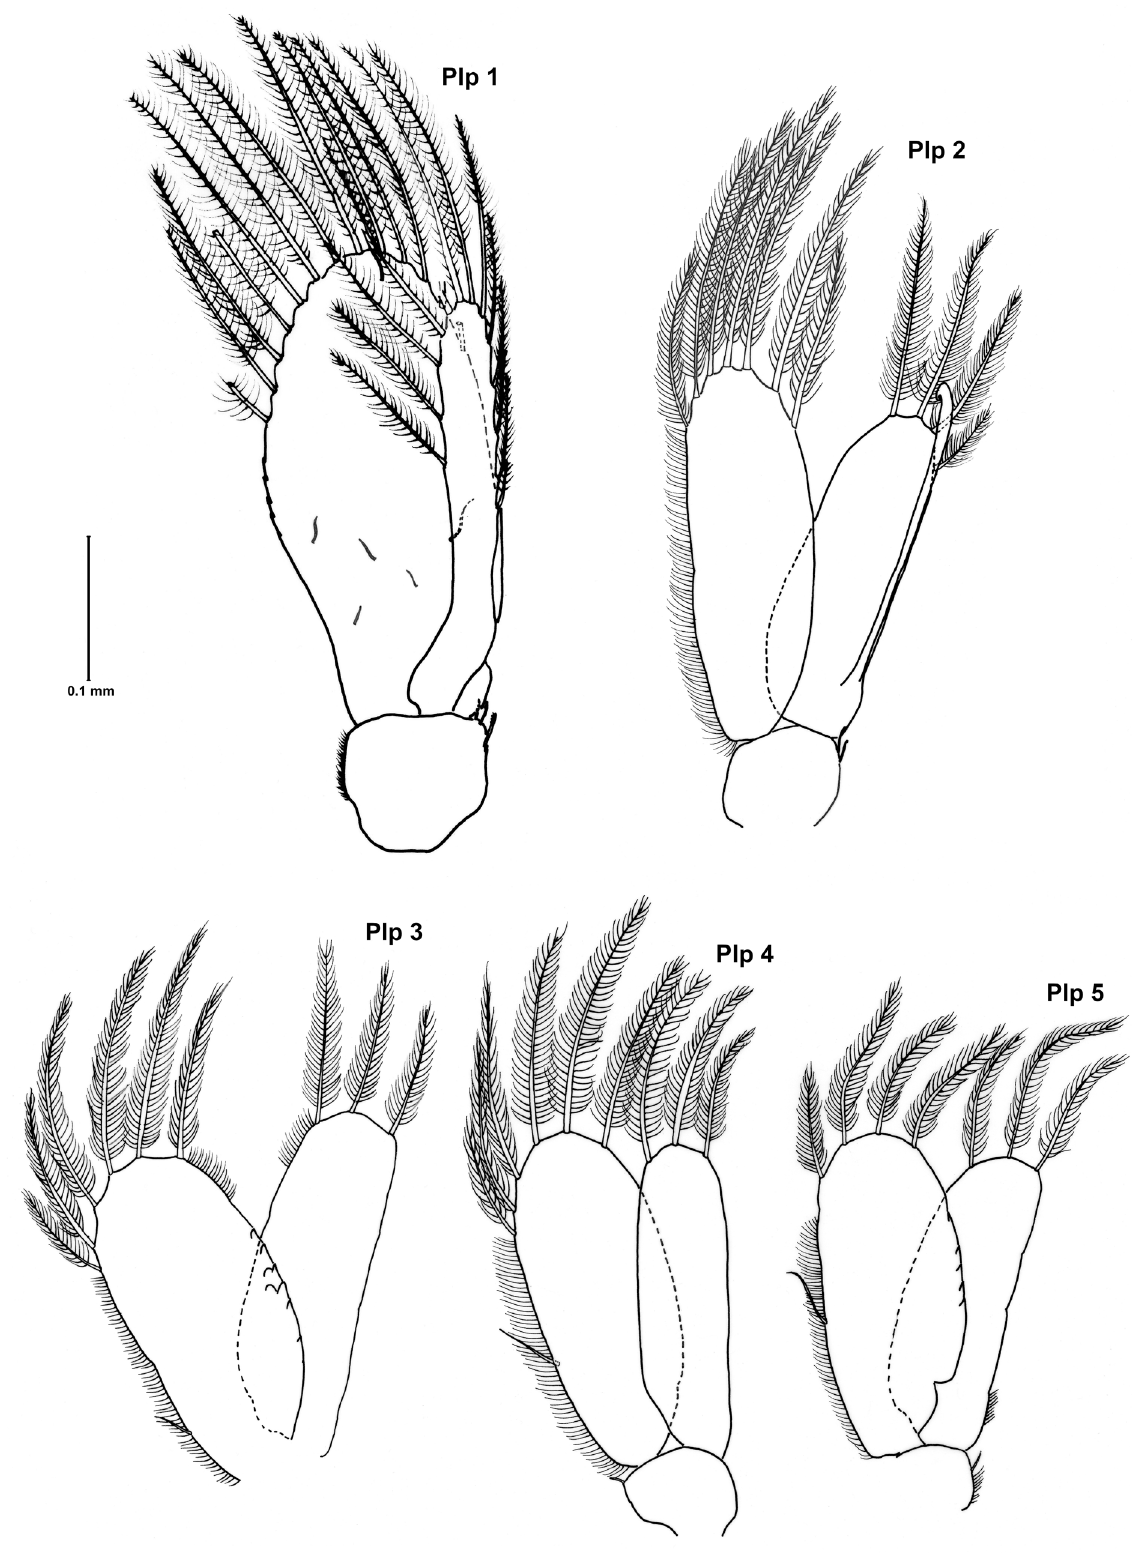
Fig. 29. Colanthura gerungi sp. nov., ♂, holotype (MZB Iso 109). Abbreviation: Plp1–Plp5 = pleopods